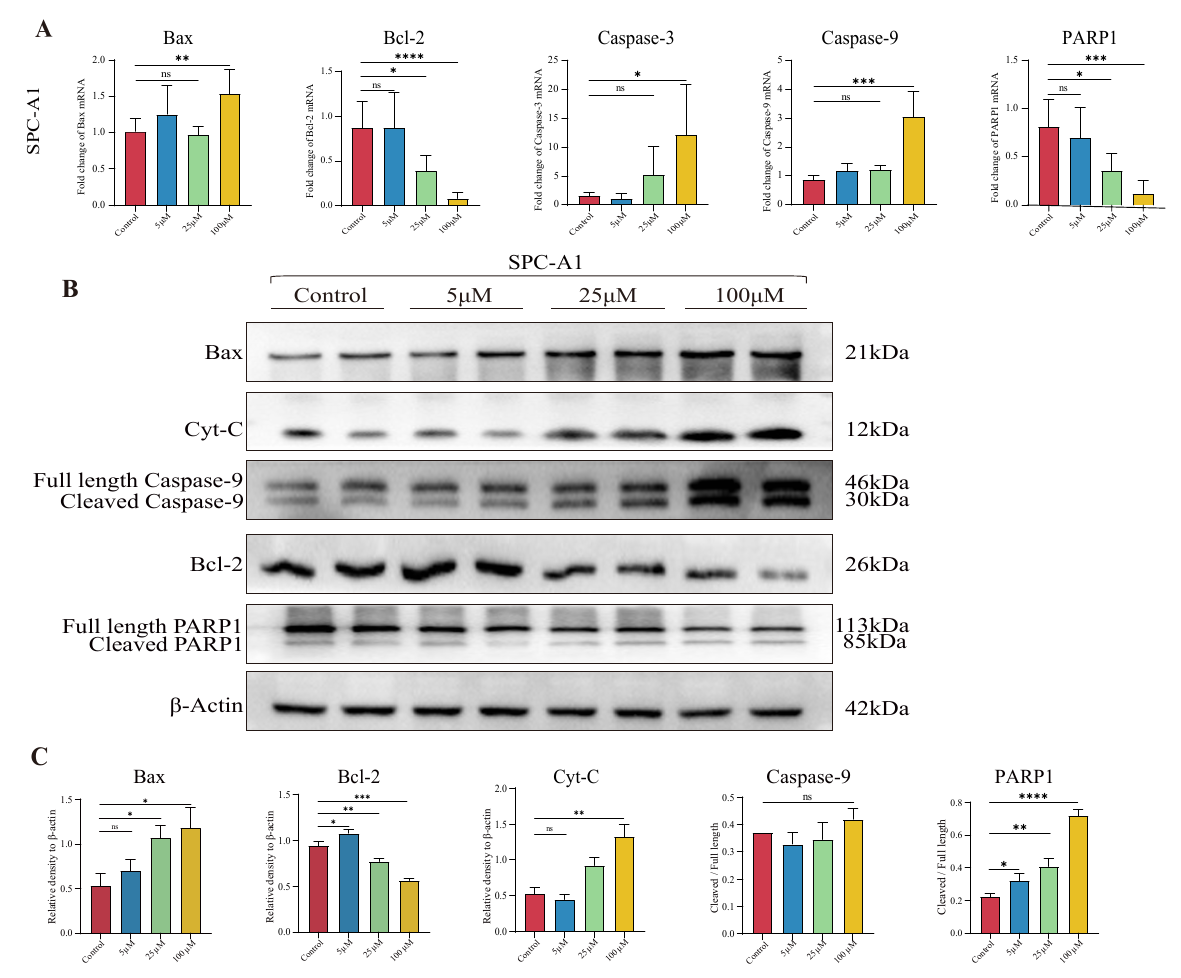
Figure 5. TAX regulates the key apoptosis regulators of SPC-A1 ( A ) The expression of several key apoptosis regulators was detected using RT-qPCR after the treatment of TAX for 48 h in SPC-A1 cells. ( B , C ) The expression of several key apoptosis regulatory proteins in SPC-A1 cells was detected using western blotting after the treatment of TAX for 48 h. Images were quantified and statistically analyzed. Ns, not significant, * p < 0.05, ** p < 0.01, *** p < 0.001, **** p < 0.0001. (Student’s t -test). Data are presented as mean ±